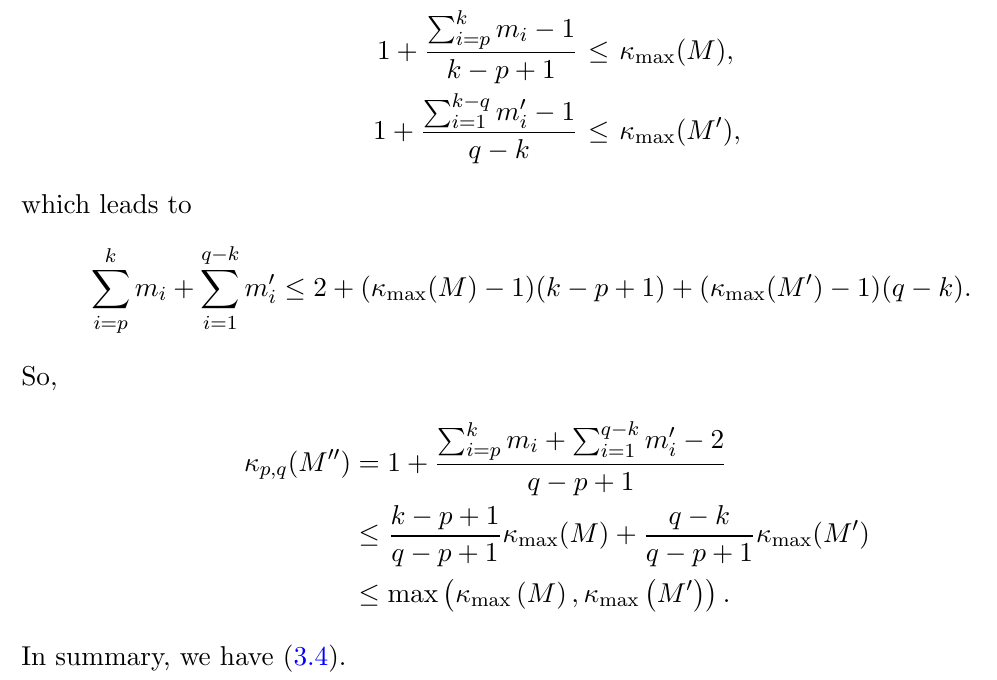
h 1 i h 1 1 i and , one can derive tensor constraint 4 3 3